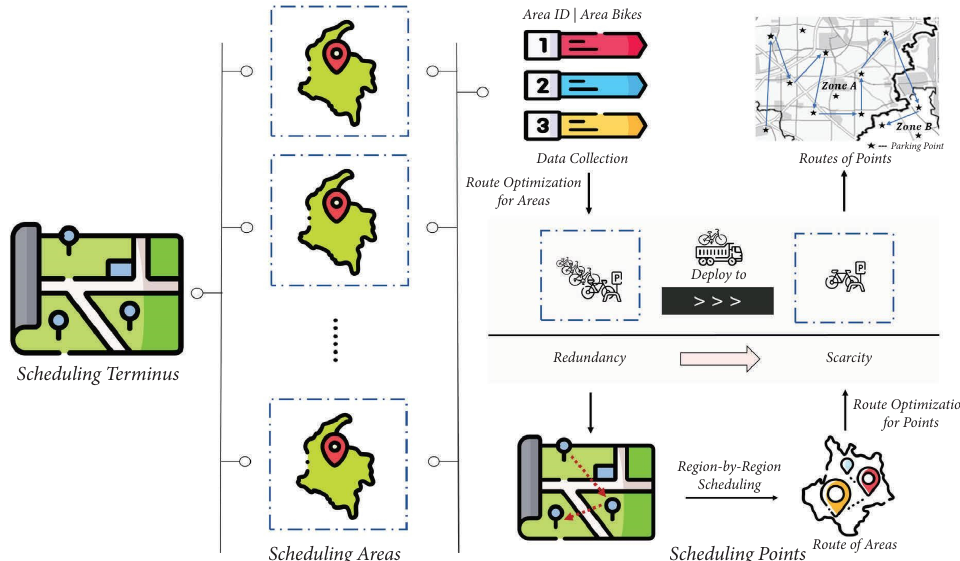
Figure 3: Te schema of HATB